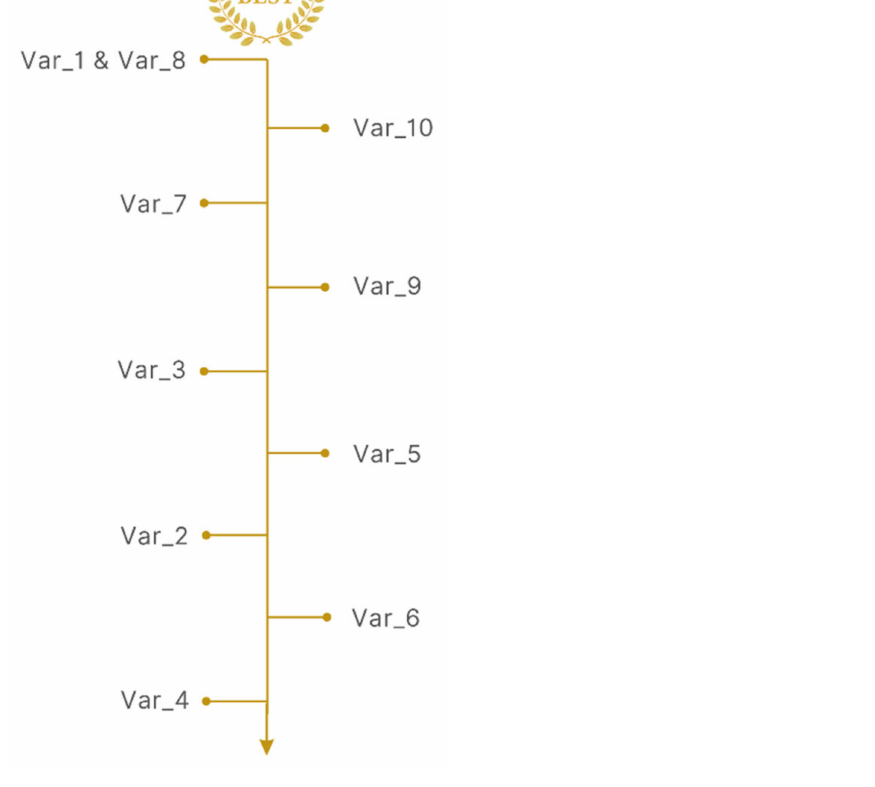
Figure 4. The final ranking of vehicle models from the point of view of the surveyed